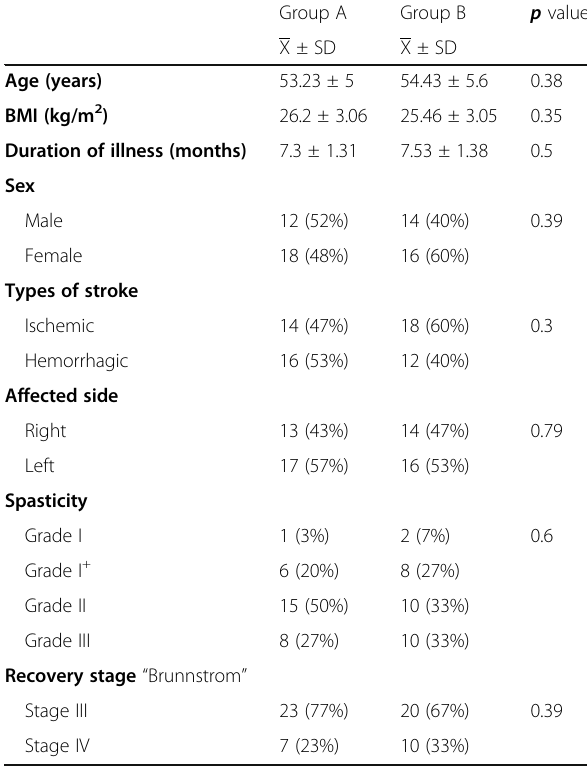
Table 1 Basic characteristics of all